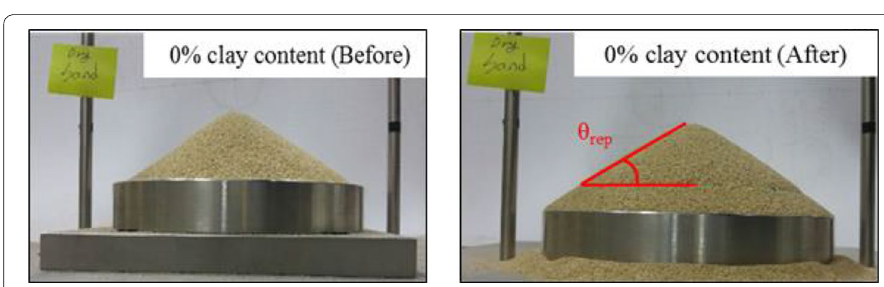
Fig. 5 Angle of repose test for Jumunjin sand at 0% clay